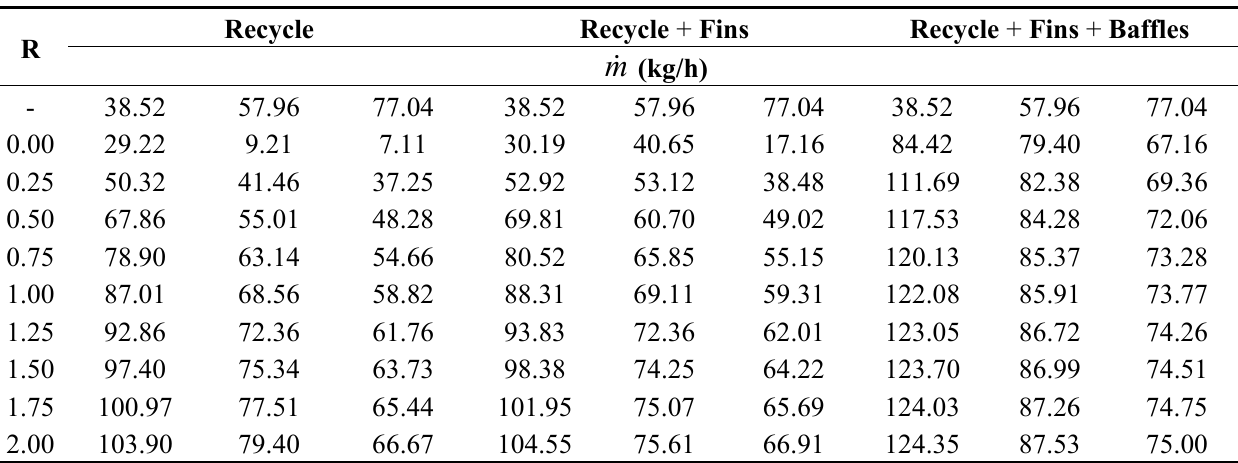
Table 4. Theoretical predictions of heat-transfer efficiency improvement I = 1100W/m 2 I 0